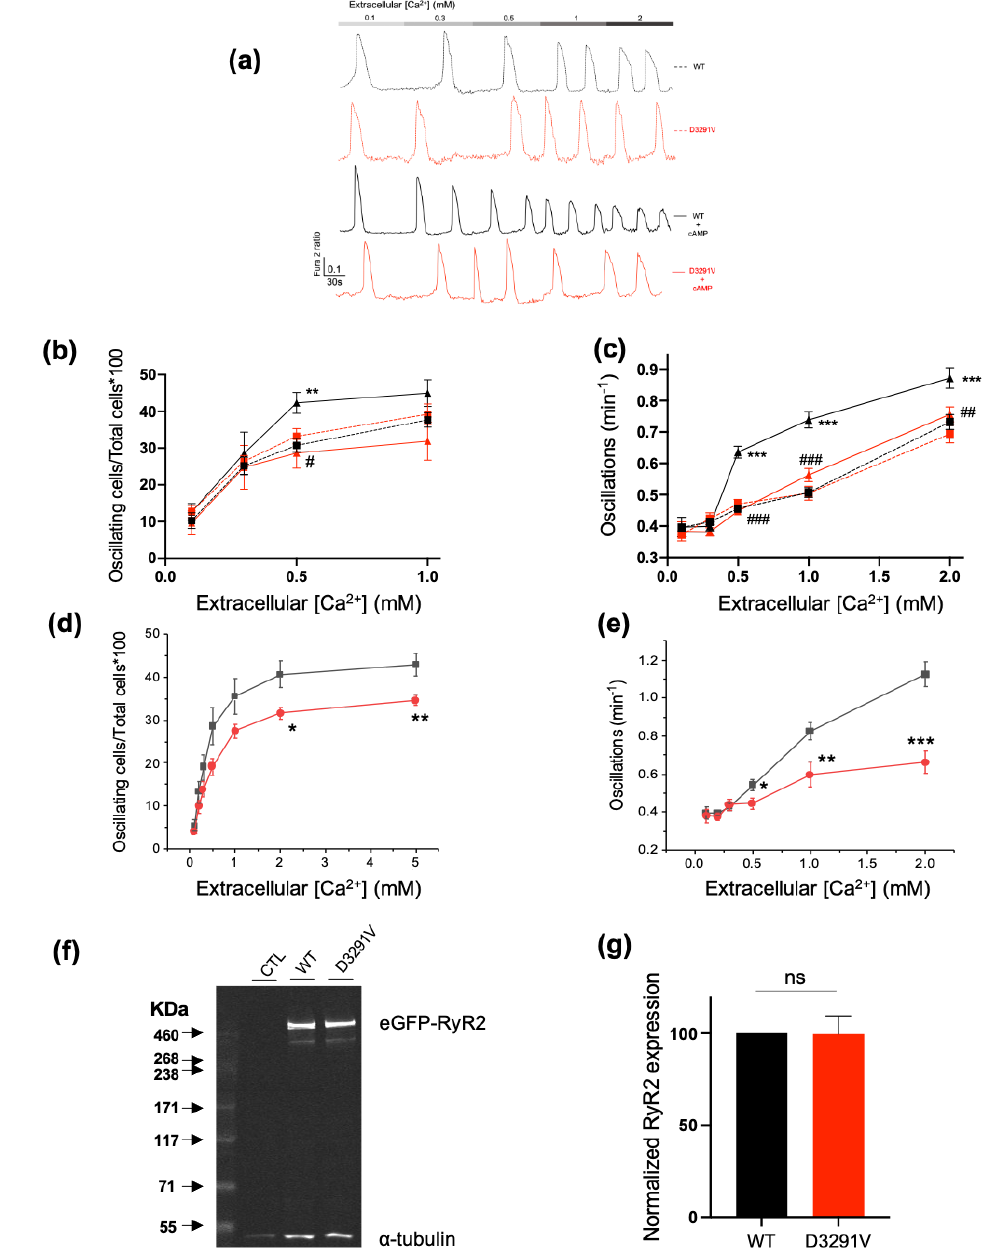
Figure 4. Functional study of D3291V-RyR2 channel in HEK293 cells. ( a ) Representative traces of Ca 2+ release under basal conditions and after cAMP treatment. ( b ) Percentages of oscillating WT-RyR2 (n = 29 dishes) and D3291V-RyR2 cells (n = 23 dishes) at different Ca 2+ concentrations (0.1-1 mM) under basal conditions or challenged by 250 µM 8-bromo-cyclic AMP (cAMP). WT: black squares and dotted lines; WT + cAMP: black triangles and solid lines; D3291V: red squares and dotted lines; D3291V + cAMP: red triangles and solid lines. ( c ) Number of oscillations per min of WT-RyR2 (n = 300 cells) or D3291V-RyR2 cells (n = 265 cells) at different Ca 2+ concentrations (0.1-2 mM) under basal conditions or challenged by 250 µM cAMP. ( d ) Percentages of oscillating WT-RyR2 (n = 29 dishes) (black squares) and D3291V-RyR2 (n = 23 dishes) (red circles) cells at different concentrations of Ca 2+ (0.1-1 mM) challenged by 5 µM forskolin. ( e ) Number of oscillations per minute of WT-RyR2 (n = 300 cells) (black squares) or D3291V-RyR2 cells (n = 265 cells) (red circles) at different Ca 2+ concentrations (0.1-2 mM) under basal condition or challenged by 5µM forskolin. ( f ) Representative Western blot of total proteins extracted from HEK293 cells transfected with RYR2-WT or RYR2-D3291V plasmids (n = 12). ( g ) Western blot quantification of RyR2 expression normalized to α-tubulin expression. Statistical significance denoted as WT compared to WT+ cAMP: * p < 0.05, ** p < 0.01, *** p < 0.001. WT + cAMP compared to D3291V + cAMP: ## p < 0.01, ### p < 0.001.